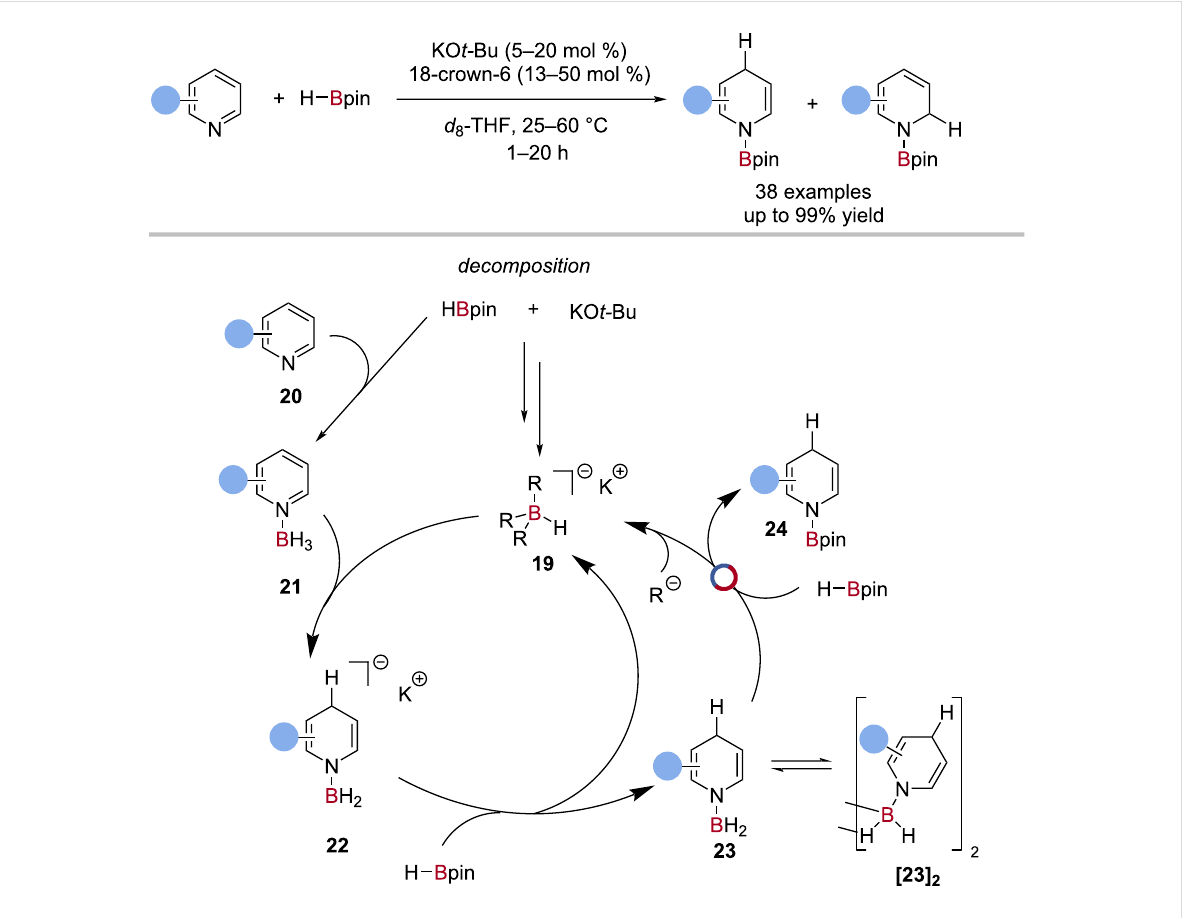
Scheme 6: Alkoxide-promoted hydroboration of heterocycles and the proposed mechanism.